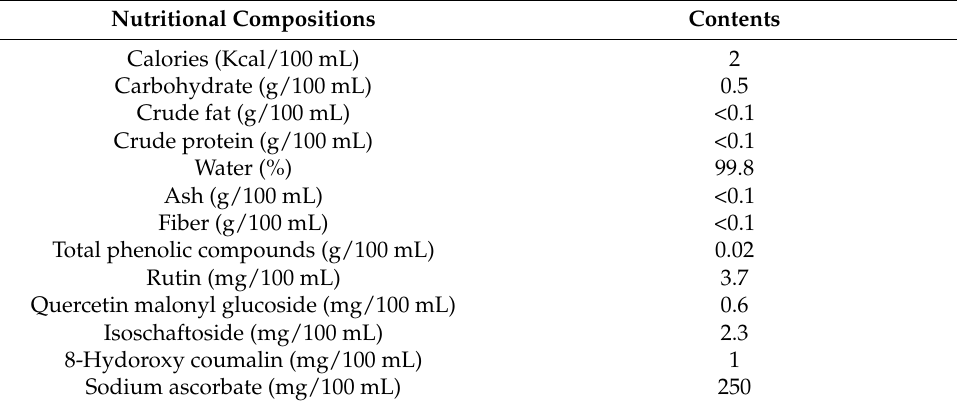
Table 1. Nutritional composition of fig leaf